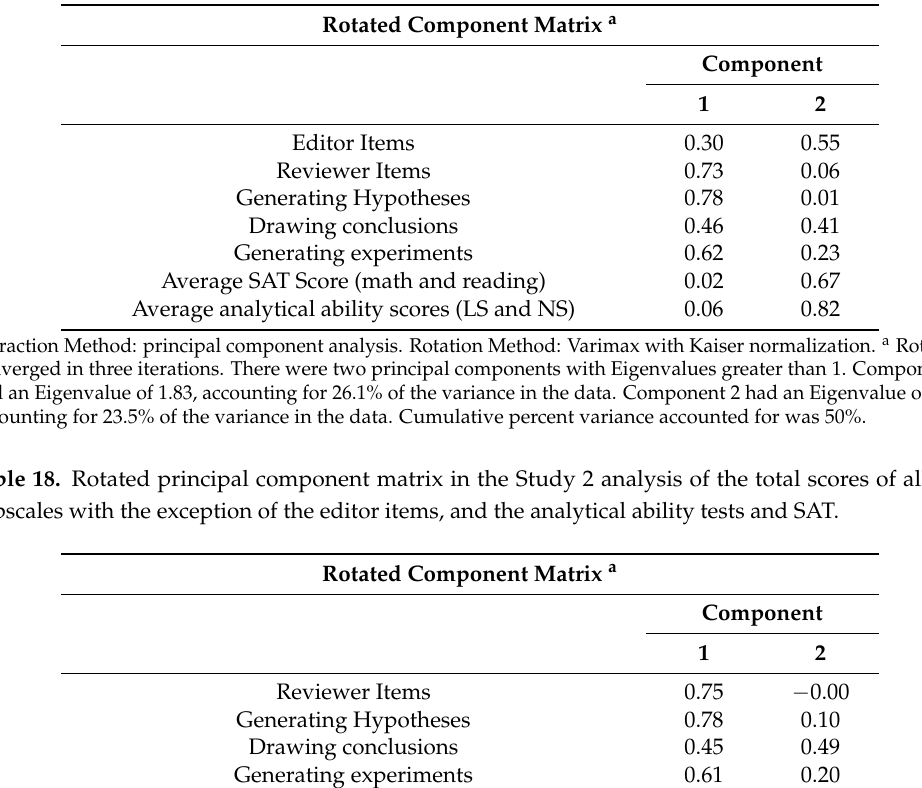
Table 17. Rotated principal component matrix in the Study 2 analysis of the total scores of all our subscales (including editor and reviewer items) and the analytical ability tests.